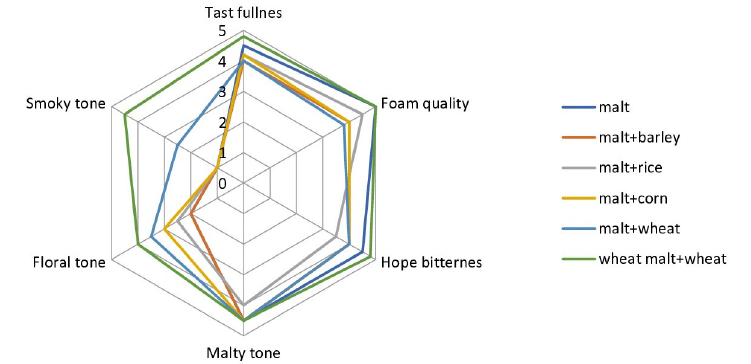
Figure 4. The beer samples taste profiles.